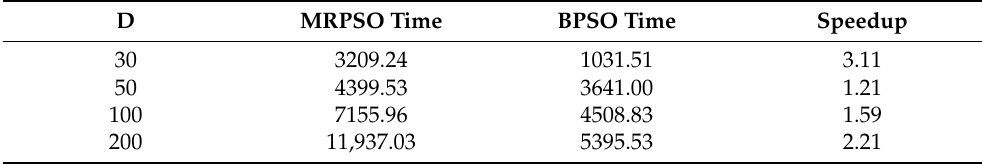
Table 10. MRPSO and BPSO running time and speedup on 𝑓 (cid:2869) .